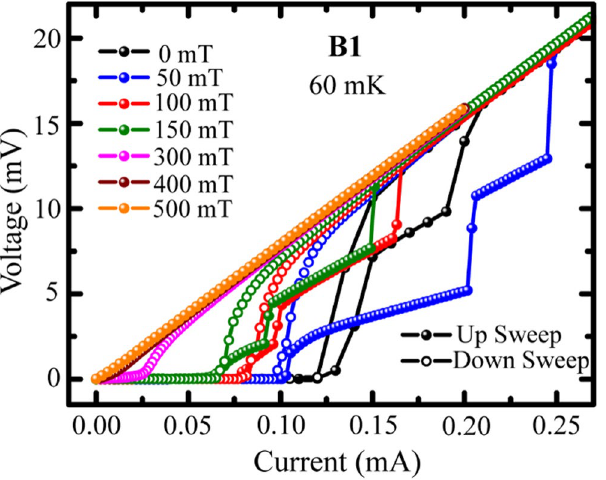
Figure 6. IVC s for sample B1 under perpendicular magnetic field measured at 60